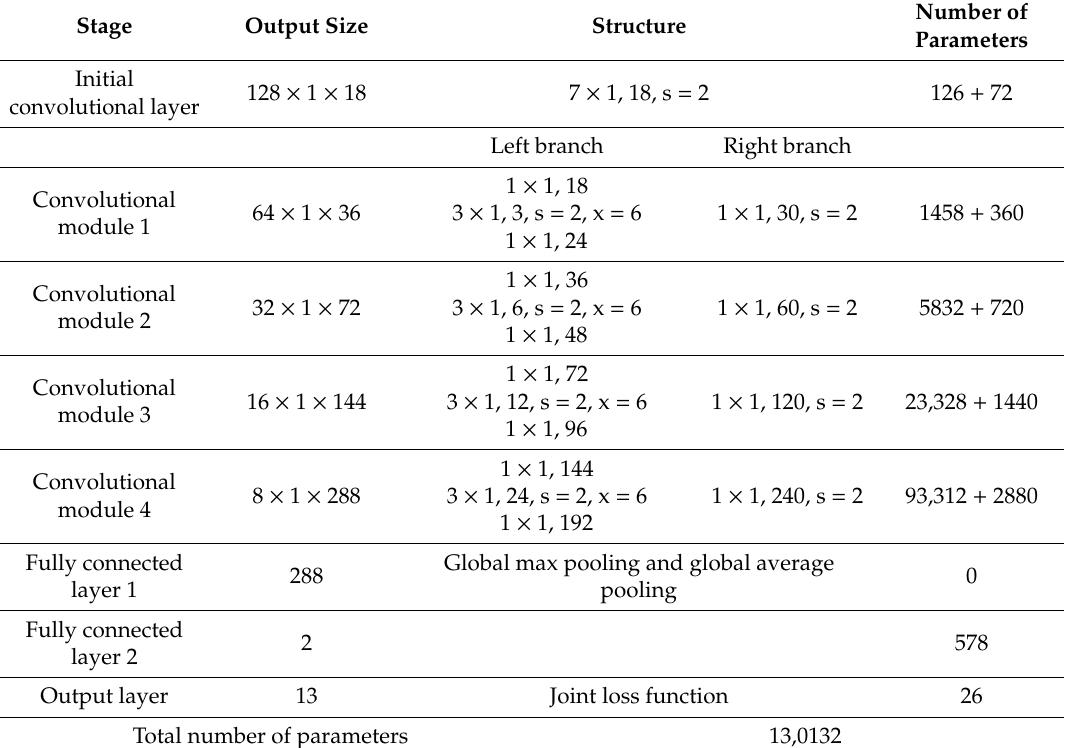
Table 9. Details of structure and parameters of each stage in model C.